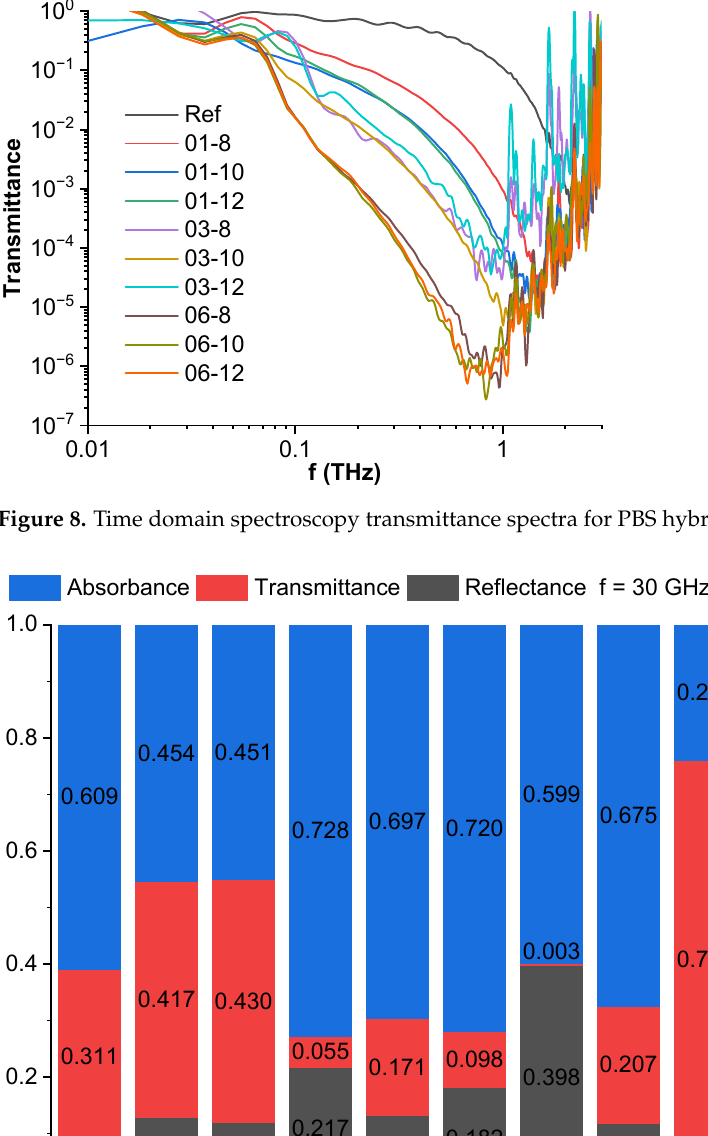
Figure 8. Time domain spectroscopy transmittance spectra for PBS hybrid nanocomposites.